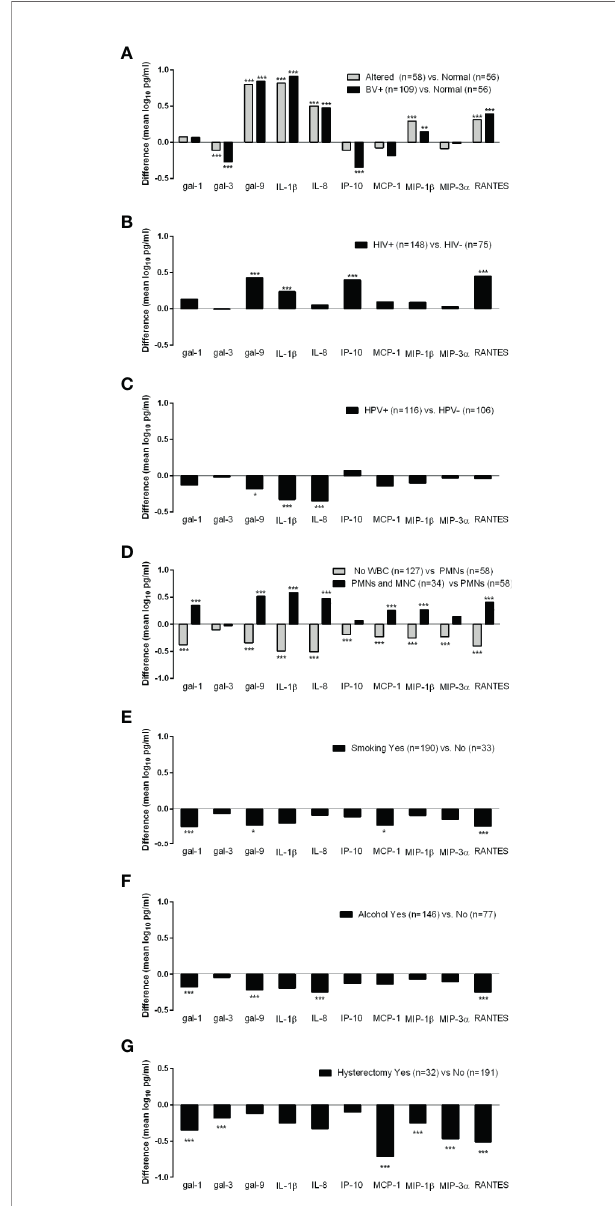
FIGURE 2 | Differences in levels of immune mediators (mean log 10 pg/ml) measured at the incident TV visits strati fi ed by BV (A) , HIV (B) , HPV (C) , presence of white blood cells (WBC) including polymorphonuclear (PMNs) and mononuclear (MNC) cells (D) and hysterectomy (G) status at the time of immunologic assessment, and by cigarette smoking (E) and alcohol consumption (F) during the 6 months preceding the immunologic assessment. Differences were assessed using ordinary least squares linear regression (ANOVA) with *p < 0.05, **p < 0.01, and ***p <